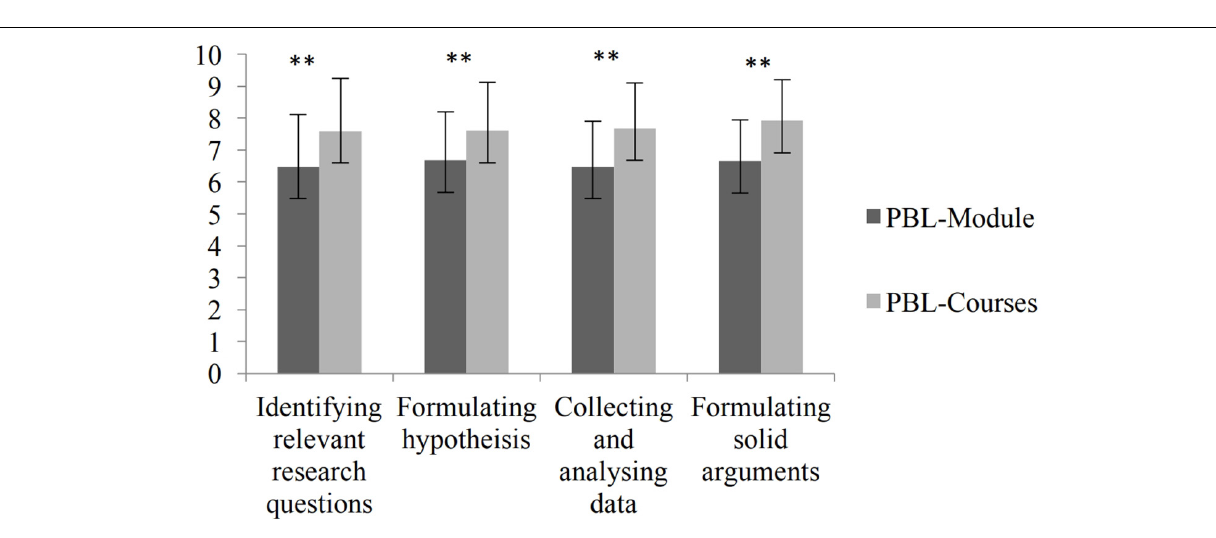
FIGURE 2 | Mean scores given by students in the research skills dimension in the PBL-module ( n = 330 students) and PBL-Courses ( n = 277 students). ∗∗ p < 0.01 (IRQ, p = 4.9 × 10 − 15 ; FH, p = 3.08 × 10 − 13 ; CAD, p = 5.6 × 10 − 22 ; FSA, p = 7.4 × 10 − 27